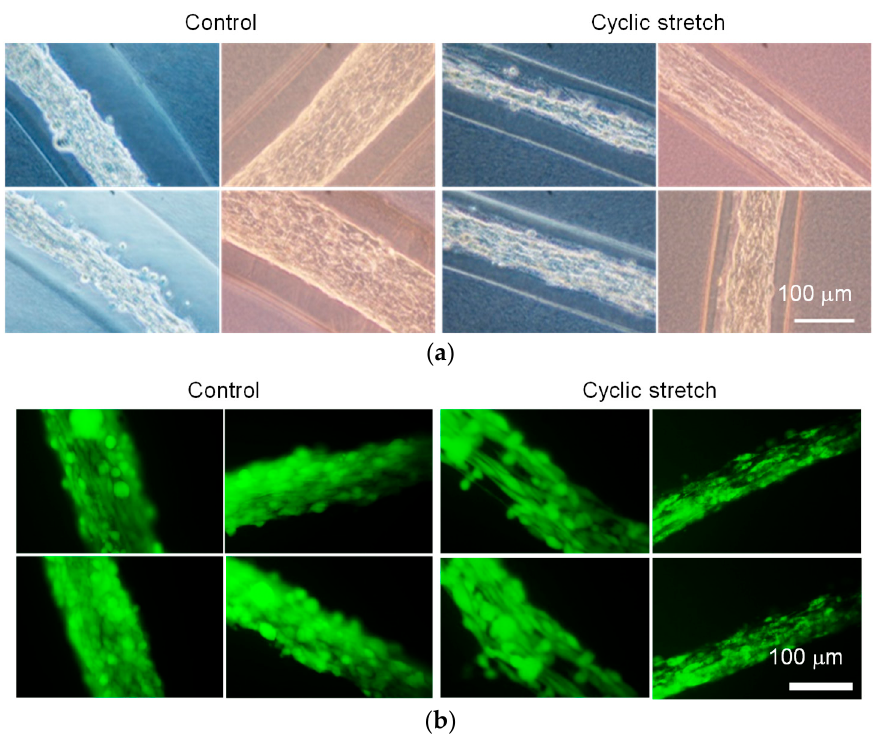
Figure 5. ( a ) Phase-contrast and ( b ) fluorescent images (calcein-AM staining) of C2C12-cell laden hydrogel fibers subjected to cyclic stretch. Scale bar: 100 μ m.